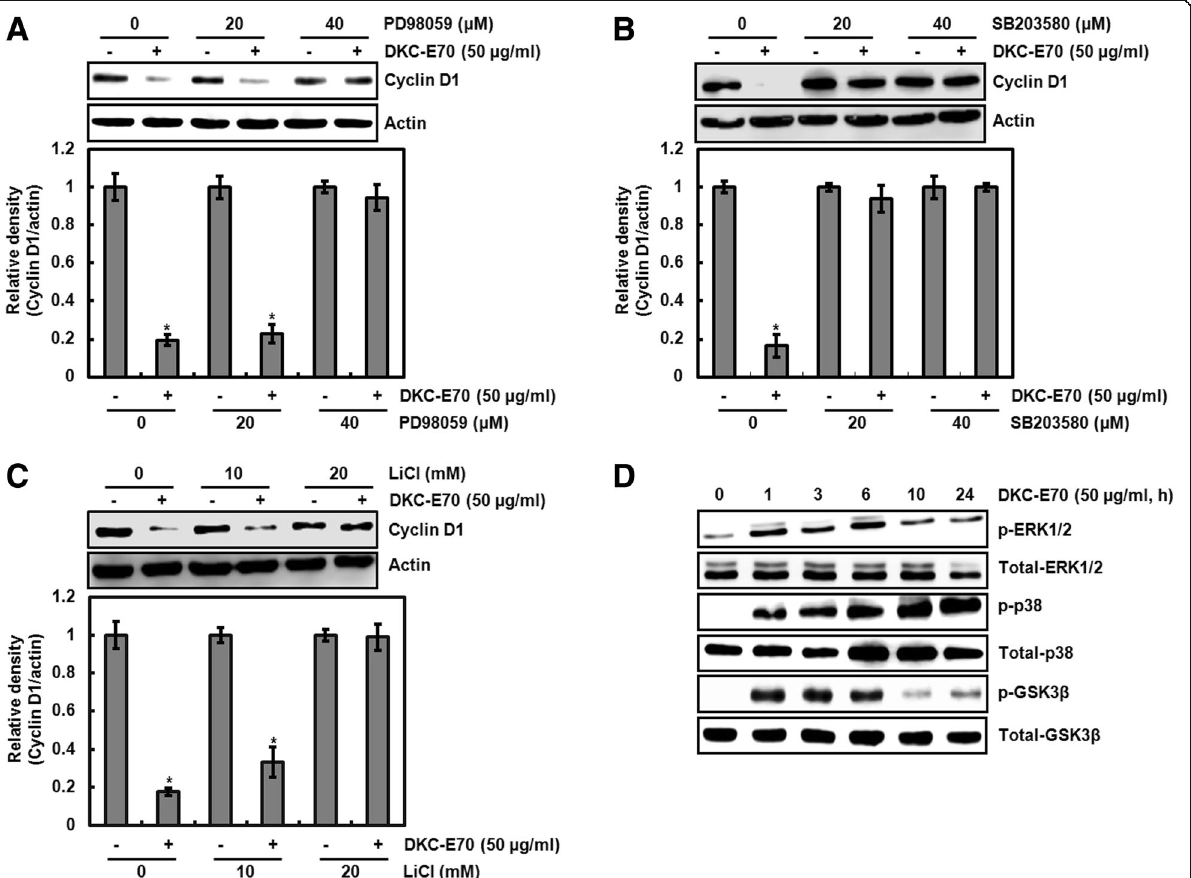
Fig. 4 Cyclin D1 degradation by DKC-E70 is dependent on the activation of ERK1/2, p38 and GSK3 β . a - c HCT116 cells were pretreated with PD98059 as an ERK1/2 inhibitor ( a ), SB203580 as a p38 inhibitor ( b ) or LiCl as a GSK3 β inhibitor ( c ), and then co-treated with DKC-E70 (50 μ g/ml) for 10 h. d HCT116 cells were treated with DKC-E70 (50 μ g/ml) for the indicated times. Cell lysates were subjected to SDS-PAGE and the Western blot was performed using antibodies against cyclin D1, p-ERK1/2, total-ERK1/2, p-p38, total-p38, p-GSK3 β or total-GSK3 β . Actin was used as internal control for Western blot analysis. *P < 0.05 compared to cell without DKC-E70